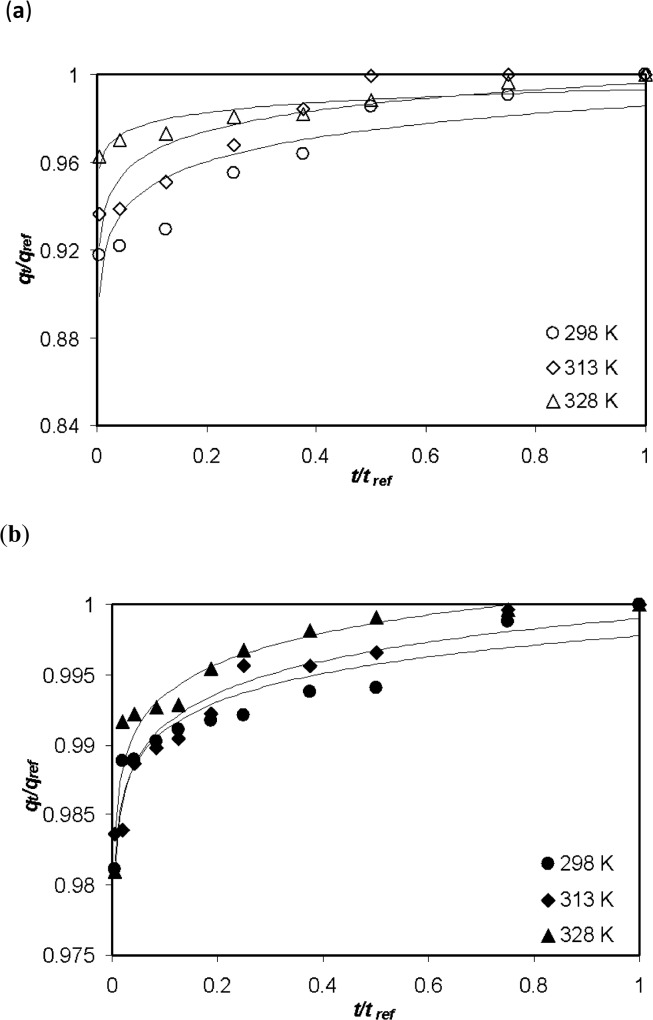
Dimensionless characteristic curves of MB sorption by (a) AC and (b) FeAC at various temperatures.